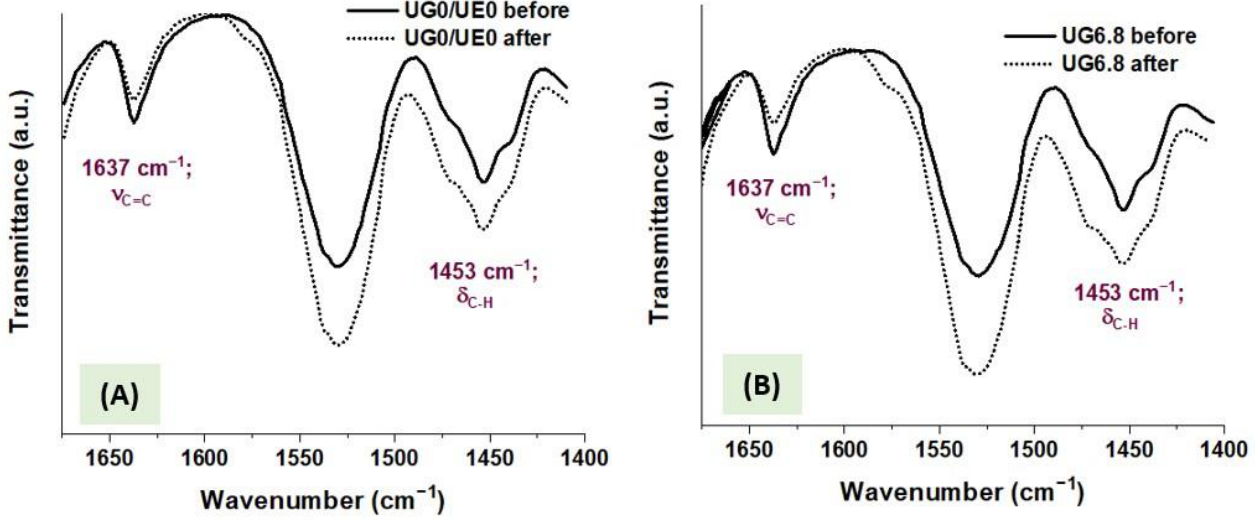
Figure 4. FTIR peaks in the range between 1675 and 1410 cm −1 of selected composites: the control (UG0 = UE0) ( A ), and composites with the highest rate of EgGMA (UG6.8) ( B ), before and after the light-curing process. Table 2. Degree of conversion (DC) of the experimental composites, UG and UE groups ( n = 5). Degree of Conversion (%); Standard Deviation in Parentheses Composite Approximate mole% of Eg = EgGMA per matrix